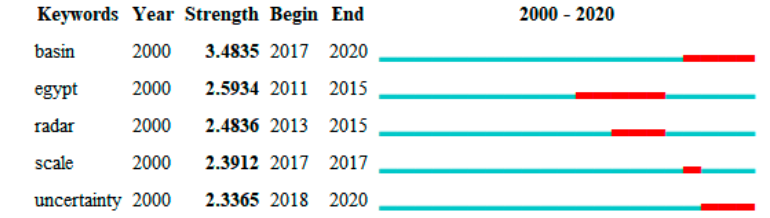
Figure 5. Keywords with the strongest citation bursts in 248 articles.